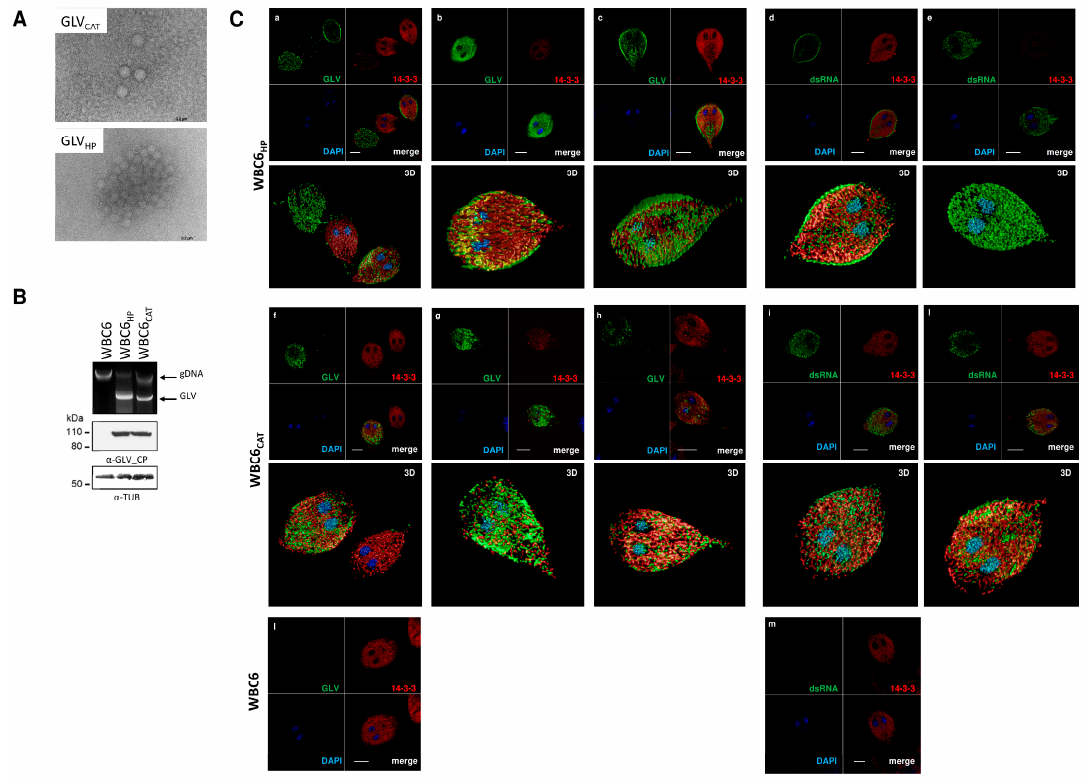
Figure 5. Infection of naïve G. duodenalis WBC6 isolate with GLV particles. ( A ) Assessment of GLV particles preparation by negative staining and TEM observation. GLV CAT (viral particle size = 42 ± 4 nm) and GLV HP (viral particle size = 44 ± 3 nm). Scale bars (0.2 µ m) are reported. ( B ) Establishment of viral infection. Upper panel, ethidium bromide stained agarose gel electrophoresis (0.8%) of the total nucleic acid (from 2 × 10 6 trophozoite/lane) isolated from naïve G. duodenalis WBC6 and after infection with GLV HP or GLV CAT particles. The band corresponding to Giardiavirus dsRNA is indicated (GLV), together with the G. duodenalis genomic DNA (gDNA). Lower panel, Western blot analysis of protein extracts (50 µ g) from trophozoites of naïve G. duodenalis WBC6 and after infection with GLV HP or GLV CAT . Protein were separated by 4–12% SDS-PAGE, electroblotted on nitrocellulose membrane and probed with anti-GLV-capsid protein_N-terminal pAb (GLV-CP_NT) and, as loading control, with mouse anti- α -tubulin ( α -TUB). Molecular size markers (kDa) are reported on the left. The analysis is representative of three independent experiments. ( C ) Immunofluorescence analysis by CLSM of fixed and permeabilized trophozoites of naïve G. duodenalis WBC6 and GLV infected WBC6 HP (panels a–e) and WBC6 CAT (panels f–m). Parasites were stained with rabbit α -g14-3-3 polyclonal serum (pseudocolor red), either with mouse α -GLV-CP_NT polyclonal serum (pseudocolor green) (panels a–c and f–h) or mouse monoclonal anti-dsRNA (J2) (pseudocolor green) (panels d–e and i–l). Nuclei were stained with DAPI (pseudocolor blue). Displayed micrographs correspond to a single z-stack. Scale bars (5 µ m) are reported; 3D, three-dimensional reconstructions of the complete stack series for each acquisition. Different fields of view (>200 cells) were analyzed on the microscope for each labeling condition, and representative results are